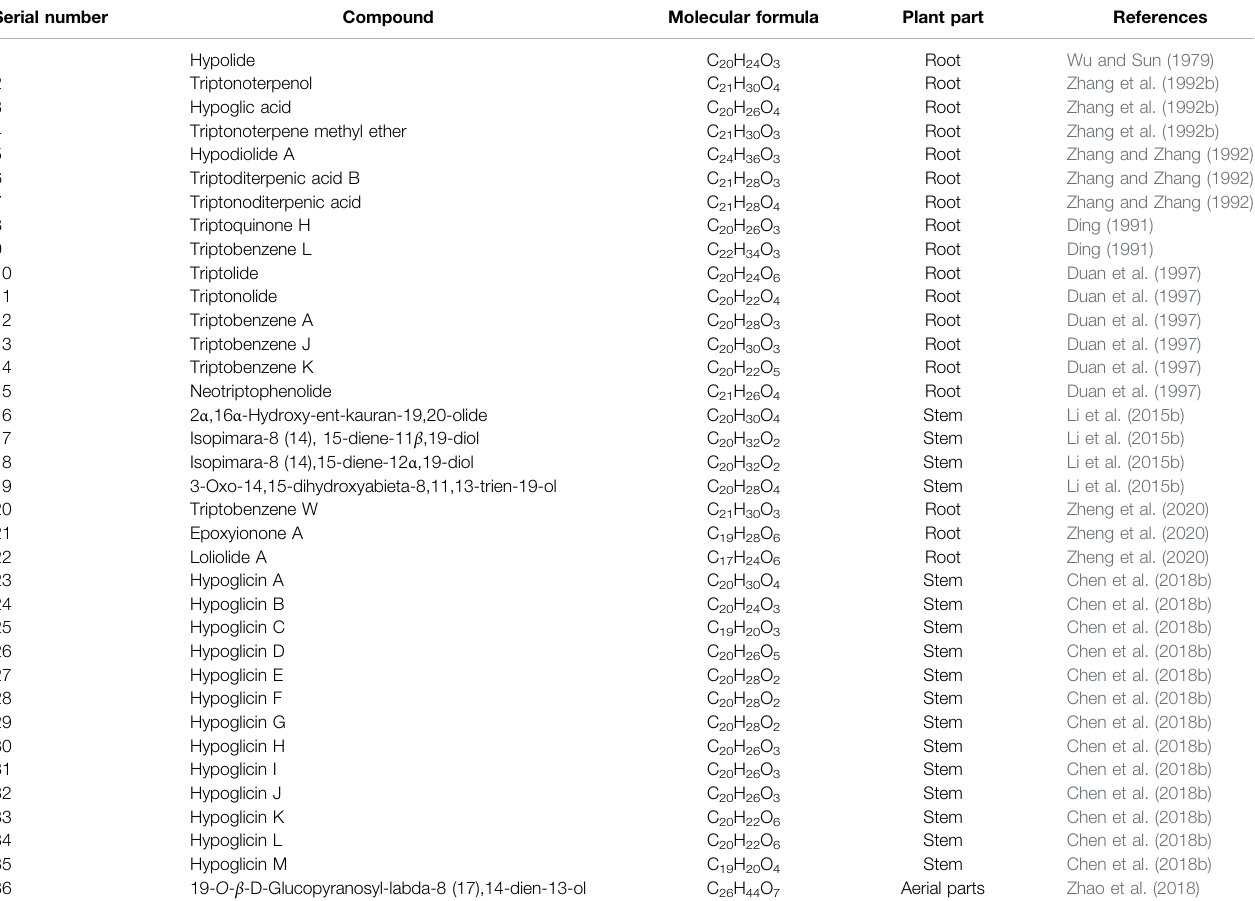
TABLE 1 | Diterpenoids isolated from Tripterygium